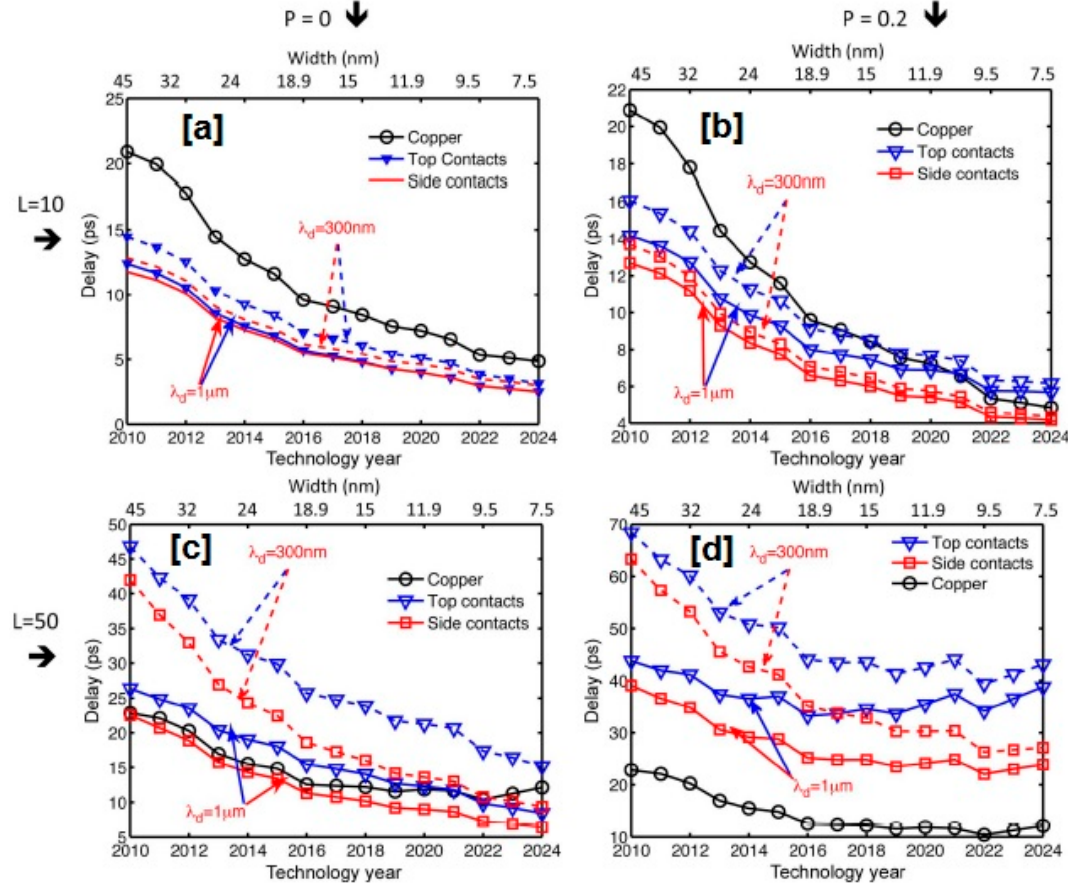
Figure 19. Impact of dimensional scaling on the delays of Cu and MLGNR interconnects with different driver sizes ( L ) and different edge-scattering probability ( P ). ( a ) L = 10, P = 0; ( b ) L = 10; P = 0.2; ( c ) L = 50, P = 0; ( d ) L = 50, P = 0.2 [7]. Reproduced with permission from [7]. IEEE, 2012.